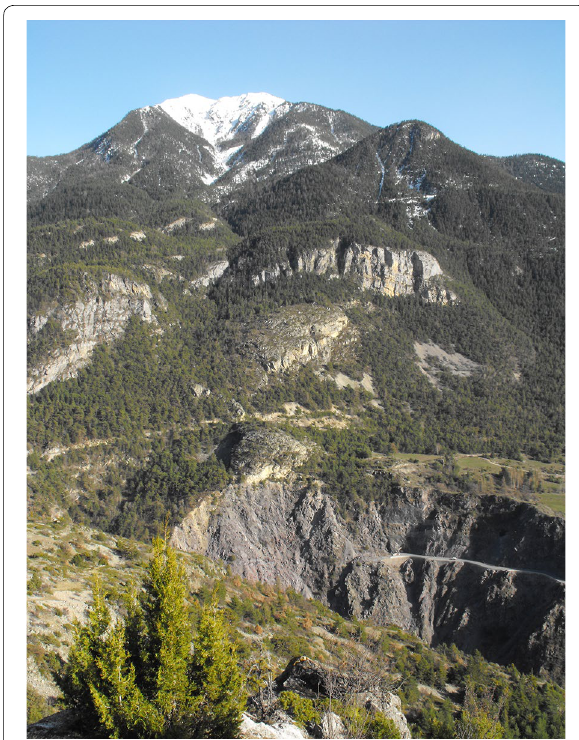
Fig. 4 A panoramic view of the left bank of the Guil gorges, taken from Pré Riond (see location on Fig. 3). The red–purple rocks are the Guil andesites. After a huge rockfall in 1948, the road was destructed, and a tunnel, aptly named “Tunnel des Roches violettes”, has been excavated into the Guil andesites. The studied rocks have been collected at the entrance of the